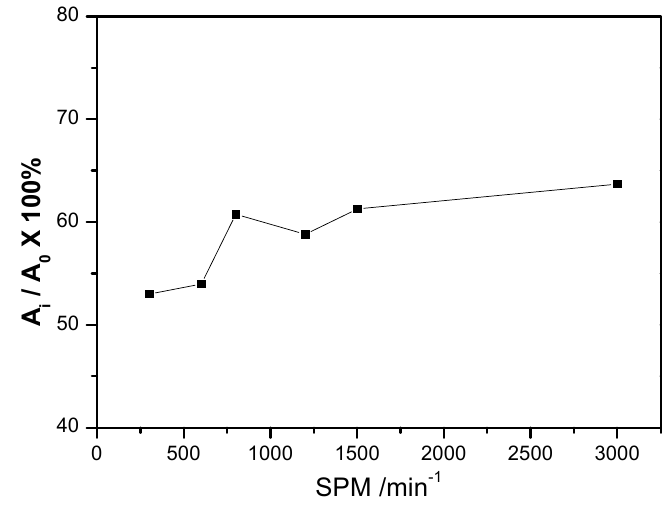
Figure 3. Influence of the blanking speed on blanked edge quality of phosphor bronze sheet.